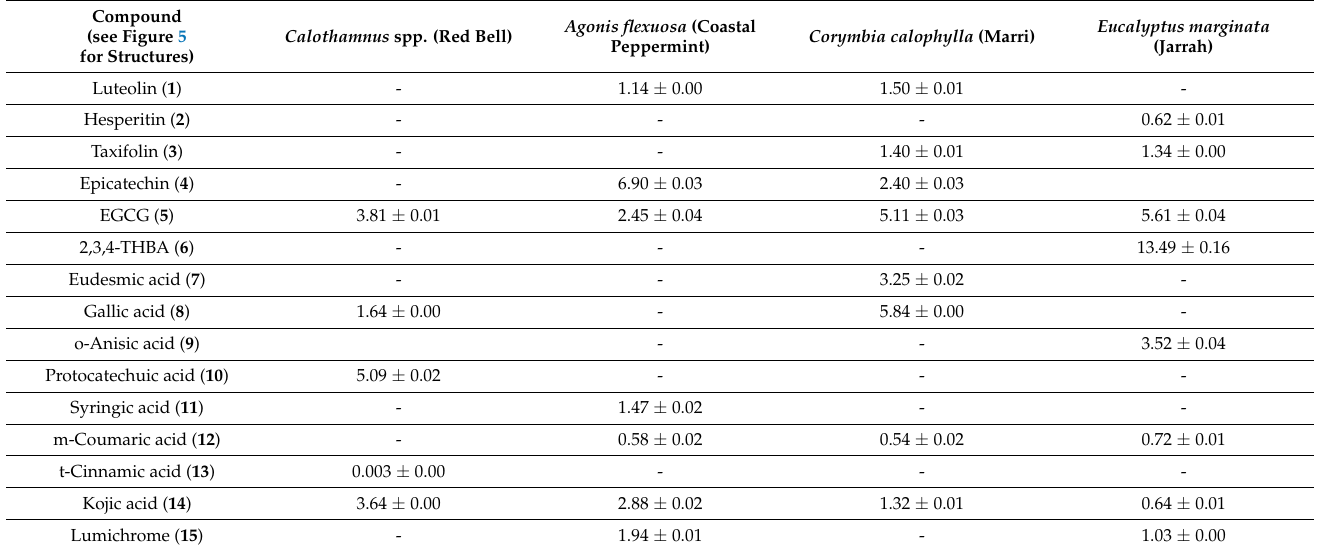
Table 6. Quantity of Specific Phenolic Constituents (in µ g/g, n = 3) identified in different Western Australian